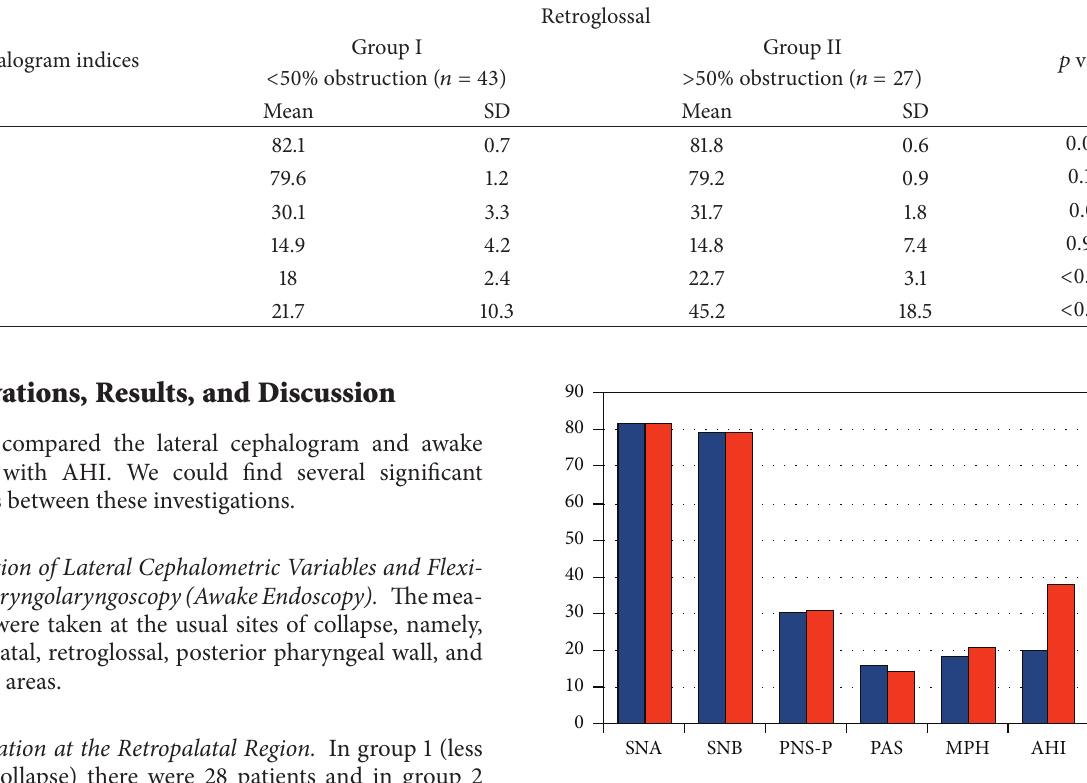
Table 3: Association of retroglossal region on flexible nasopharyngolaryngoscopy with lateral cephalometric variables.